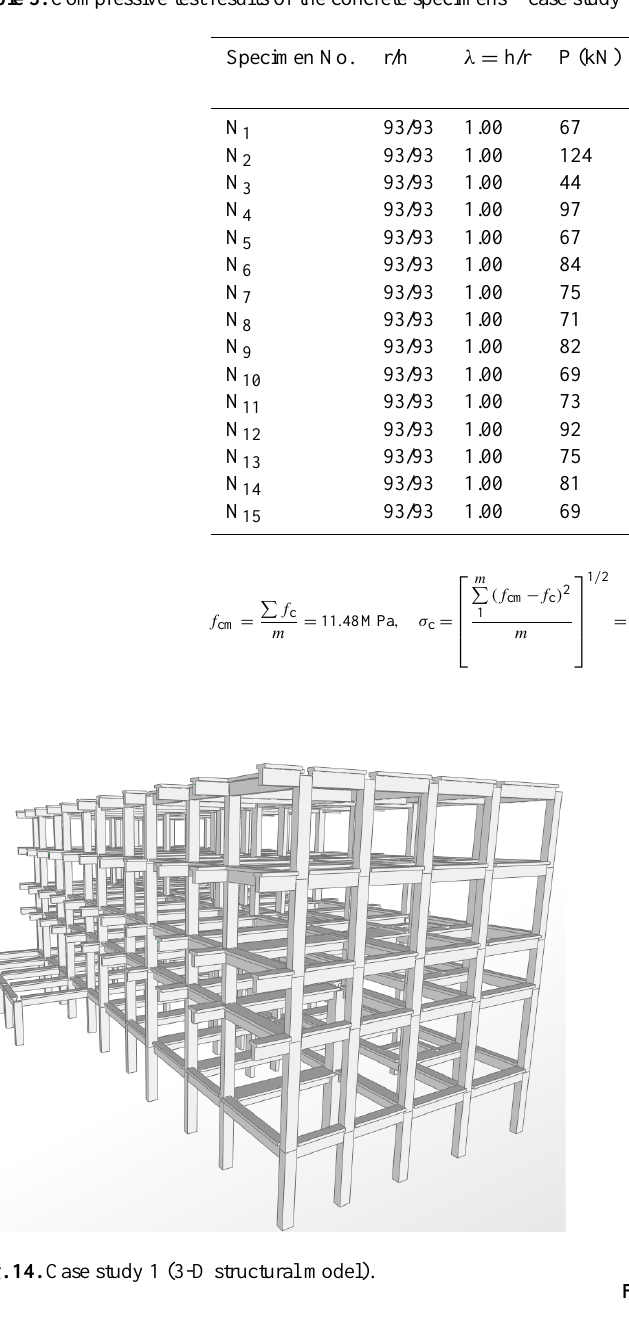
building. This method is implemented by incrementing the equivalent seismic load proportional to the multiplication of the first (domain) vibration mode shape amplitudes and story masses in the considered earthquake direction. In order to obtain lateral load–lateral top displacement curve of the sample buildings, 3-D (three-dimensional) mod- els have been created in SAP2000. Beam and column ele- ment are modeled as non-linear frame elements with